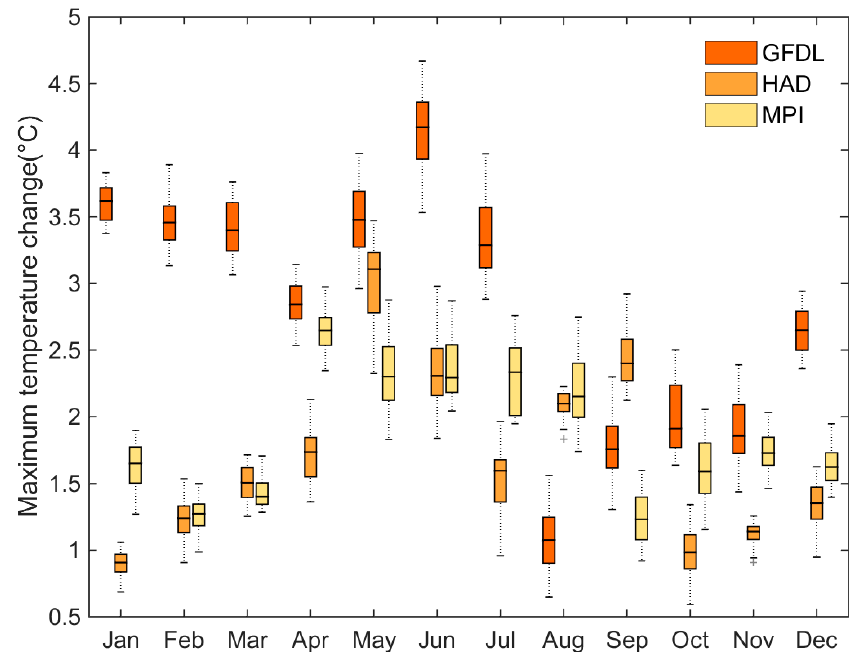
Figure 10. Distribution of maximum temperature CFs based on 20-years sampling method point in middle Awash for mid-term, 2031–2055 using the three models.